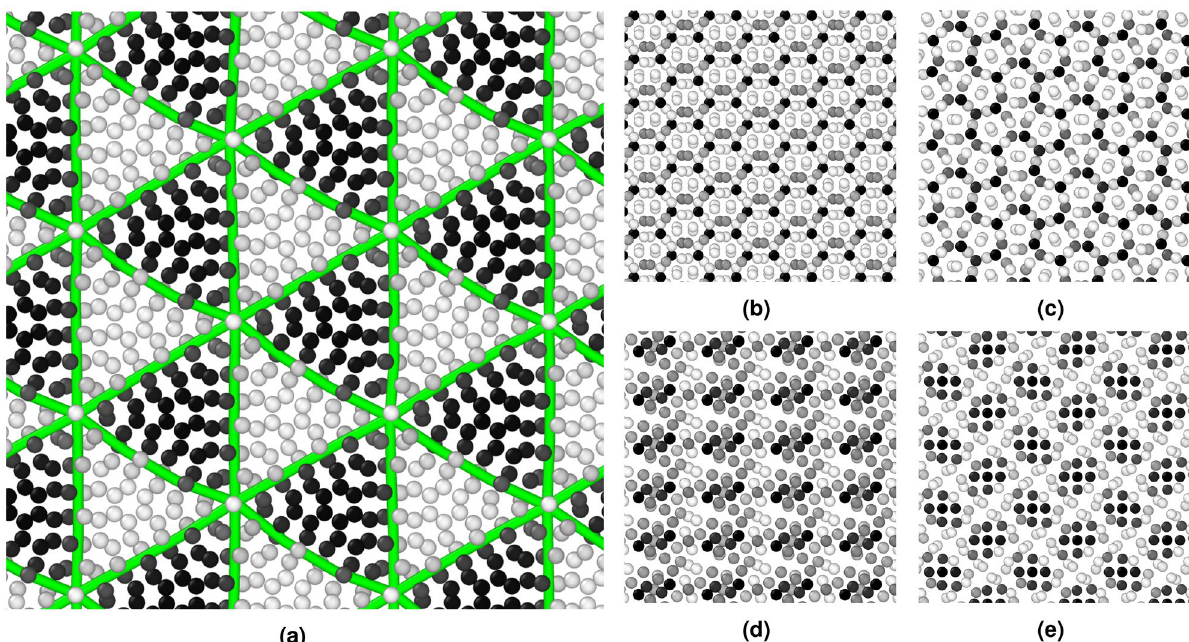
Figure 3. View of the GB plane showing the structure for select (a)–(c) [111] and (d)–(e) [110] STGBs. The structure of (a) (cid:31) 111 , (b) (cid:31) 7 , (c) (cid:31) 39 , (d) (cid:31) 9 , and (e) (cid:31) 17 STGBs are shown. Atoms are colored according to the centrosymmetry parameter, where lighter colors indicate greater deviation from local FCC ordering. For the (cid:31) 111 [111] STGB in (a) , interfacial dislocation network (green) extracted using DXA are dence (i.e., the coincidence site lattice description) 65 . Each of the two half crystals was rotated about the twist axis (i.e., the crystal y -axis given by [110] or [111]) by an equal and opposite angle θ/ 2 , where θ defines the total twist angle. The x -direction for each of the crystals after the rotation is also shown in Table 1. Projected views of the GB plane depicting the 0K equilibrated structures before mechanical deformation for five selected GBs are shown in Fig. 3. Atoms are colored according to the centrosymmetry parameter, where lighter atoms indicate greater deviations from local FCC ordering (see Supplementary Fig. S2 online for the same figure, but with atoms colored according to element type). The atomic structures for the (cid:31) 111 , (cid:31) 7 , and (cid:31) 39 [111] GBs are shown in Fig. 3a–c, respectively, whereas Fig. 3d–e shows respectively (cid:31) 9 and (cid:31) 17 [110] GBs. In Fig. 3a representing the structure of the (cid:31) 111 [111] STGB, DXA was used to reveal and characterize the interfacial dislocation net-